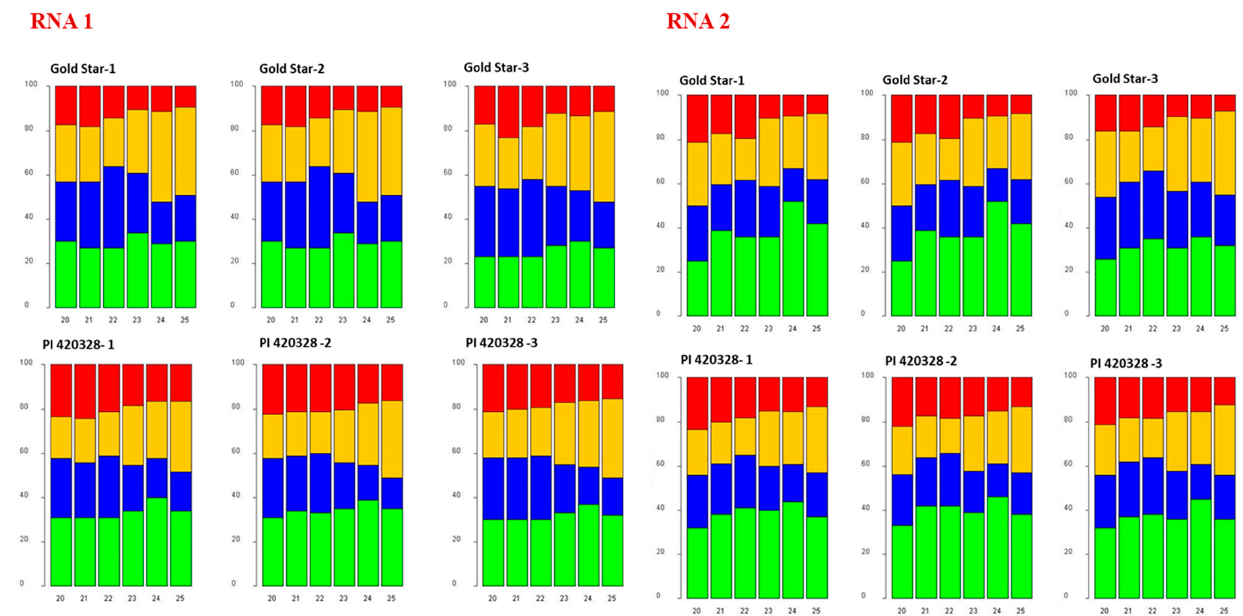
Figure 5. The 5 ′ -terminal nucleotide frequency of 20–24 nt CYSDV-derived small RNAs (sRNA) in Gold Star and PI 420328. The composite bar graphs indicate the percentage of 5 ′ U (red), 5 ′ G (orange), 5 ′ C (blue), and 5 ′ A (green) for each of the size classes of virus CYSDV-derived sRNAs.